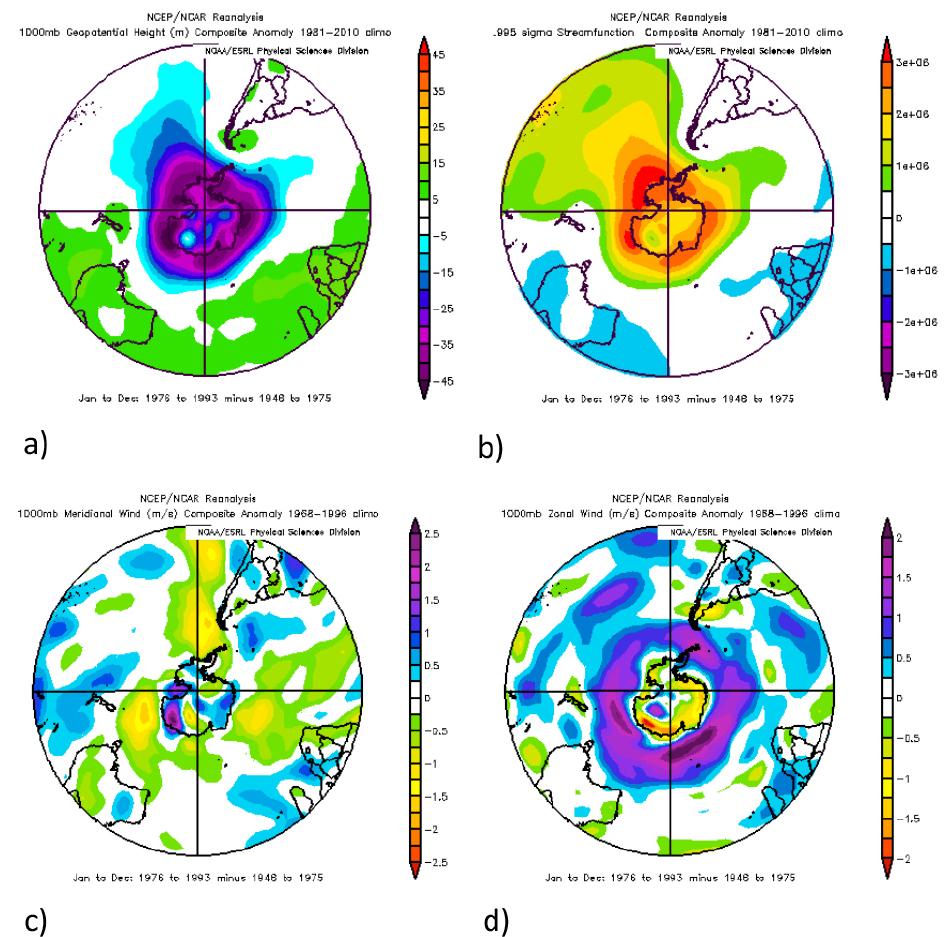
Figure 4. Difference in annual (a) geopotential height, (b) streamfunction, (c) meridional and (d) zonal wind anomalies during the